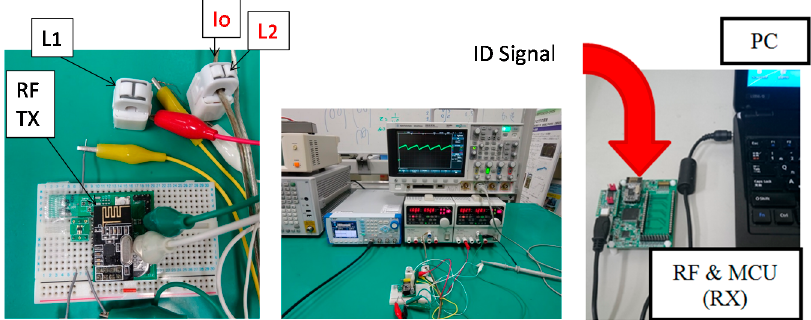
Figure 4. Measurement set up of the DCC Beat Sensor.